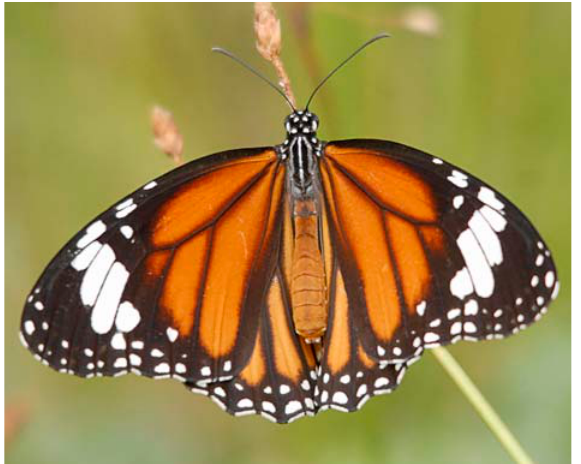
Image 11. Common Crow Euploea core